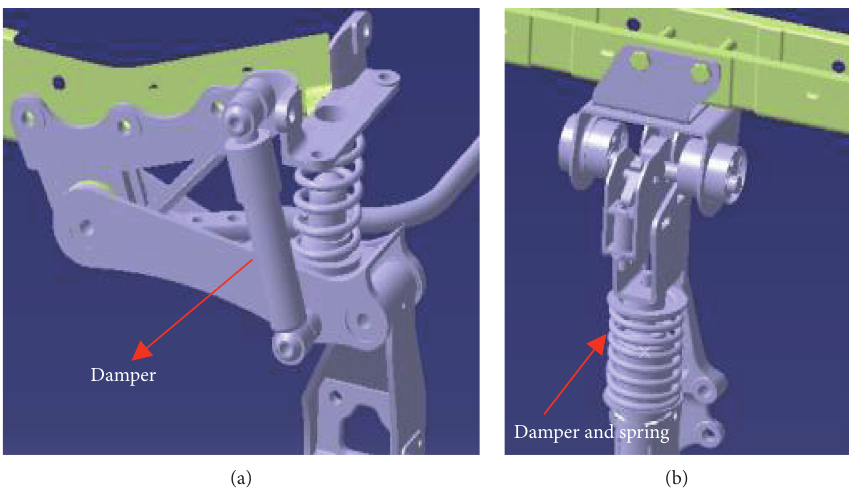
Figure 13: Front and rear suspension structure. (a) Rear mount. (b) Front